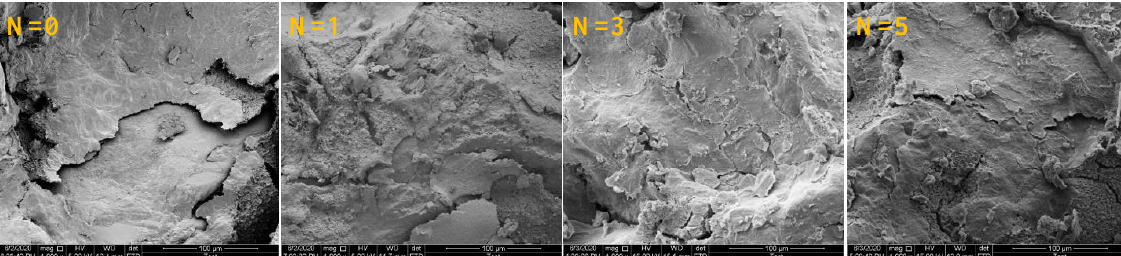
Figure 7. SEM results of specimens at different wet – dry cycles (1000×).